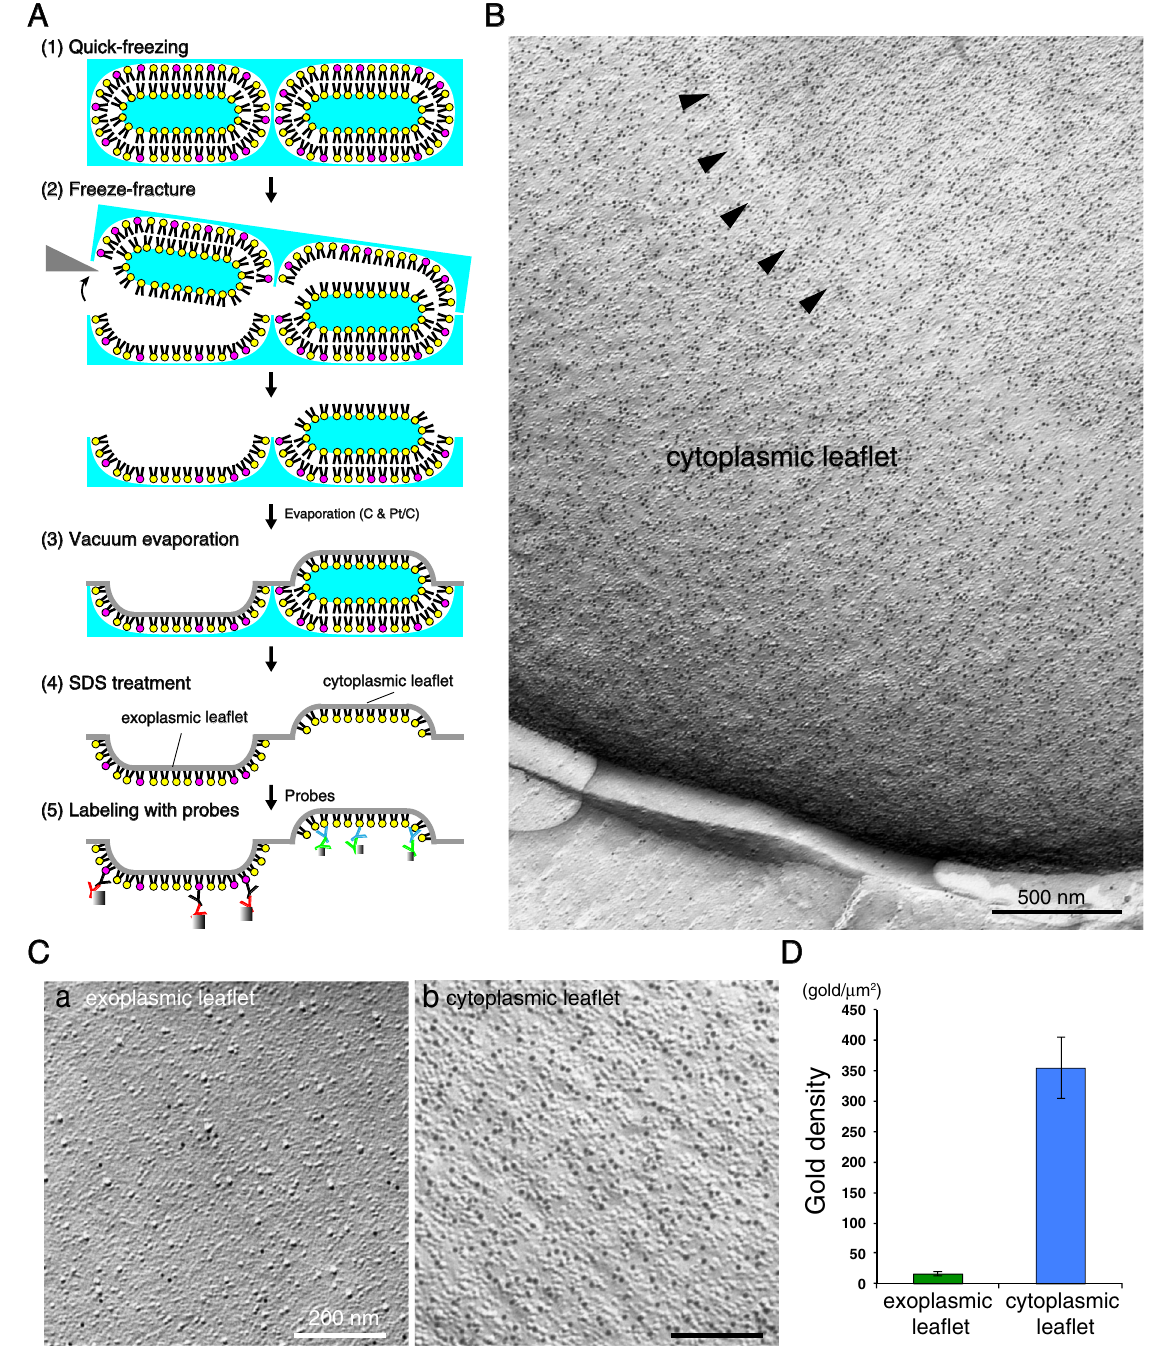
Figure 6. Localization of PtdIns(4,5)P 2 in the PF, but not the EF, in the human erythrocyte plasma membrane. ( A ) Outline of a QF-FRL method for the uninfected erythrocyte. ( B ) A micrograph of the erythrocyte plasma membrane using a freeze-fracture EM method. Arrowheads represent the depressed area on the PF of the plasma membrane, which is characteristic of human erythrocytes 61,62 . The strong labeling of GST-PLCδ1-PH (PtdIns(4,5)P 2 ) was detected on the PF of the erythrocyte plasma membrane. The labeling of PtdIns(4,5)P 2 was localized on the PF (B, Cb), but not the EF (Ca), of the erythrocyte plasma membrane. ( D ) Labeling density of PtdIns(4,5)P 2 in each leaflet of the erythrocyte plasma membrane. The labeling densities of PtdIns(4,5)P 2 on the EF (green) and the PF (blue) of the erythrocyte plasma membrane are shown. Significantly higher gold labeling densities on the PF than that of the EF of the plasma membrane were detected. Mean ± s.e.m. of three independent experiments is shown. Scale bars: 500 nm ( B ) and 200 nm ( C